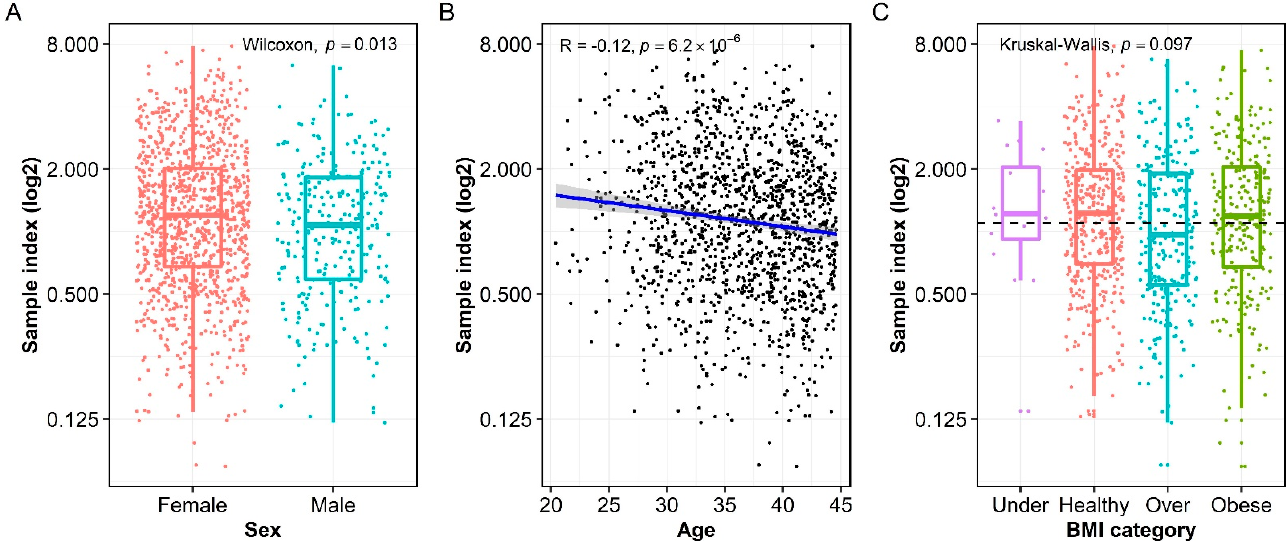
Figure 2. The influences of demographic variables on measles-specific IgG titer. ( A ) Females had a significantly higher median sample index than males. ( B ) Measles-specific IgG level was negatively correlated to the age of the cohort. ( C ) Overweight individuals (labelled as “Over”) had significantly lower IgG titer than underweight (labelled as “Under”), healthy, and obese individuals, but the difference did not reach statistical significance.